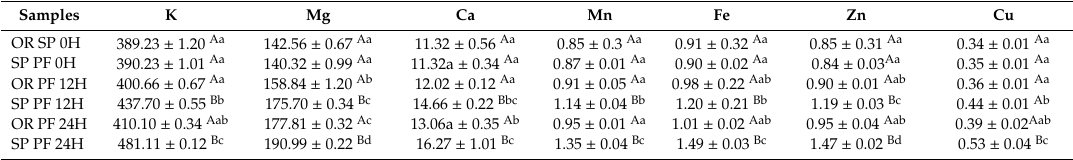
Table 4. Mineral content (mg / 100 g f.w.) of ORPF and SPPF mu ffi ns *.